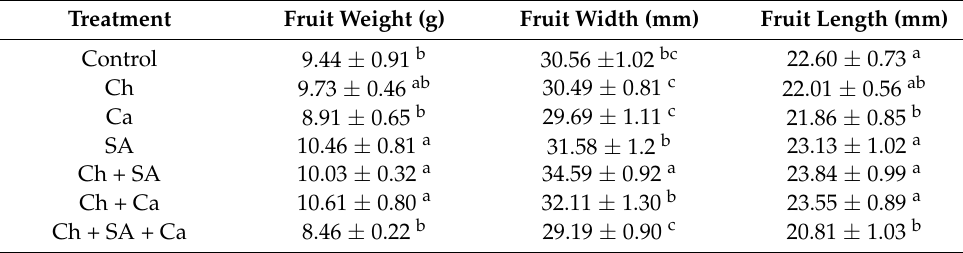
Table 1. Effects of preharvest application of natural elicitors on “Barhi” date fruit’s physical properties at